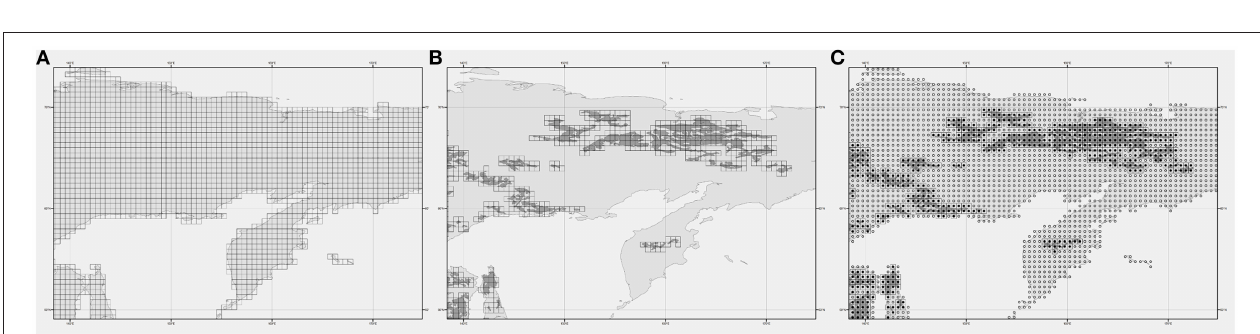
FIGURE 2 | Example of the processing chain for the creation of the Occurrence Database (ODb). (A) The initial 0.5 × 0.5 ◦ grid; (B) The selection of grid element overlapped by species polygon; (C) The final binary map of not presence (0; empty circles)—presence (1; full black